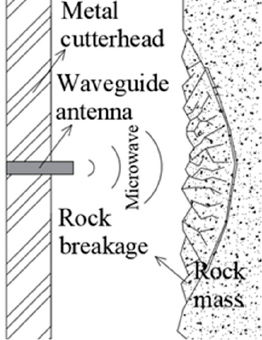
Figure 2. Schematic diagram of microwave open-ended irradiation on rock mass.